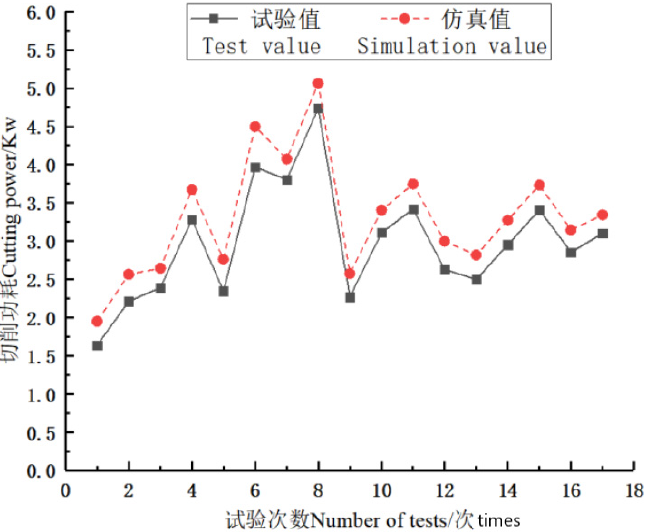
Figure 13. Comparison of power consumption in field trials and simulation